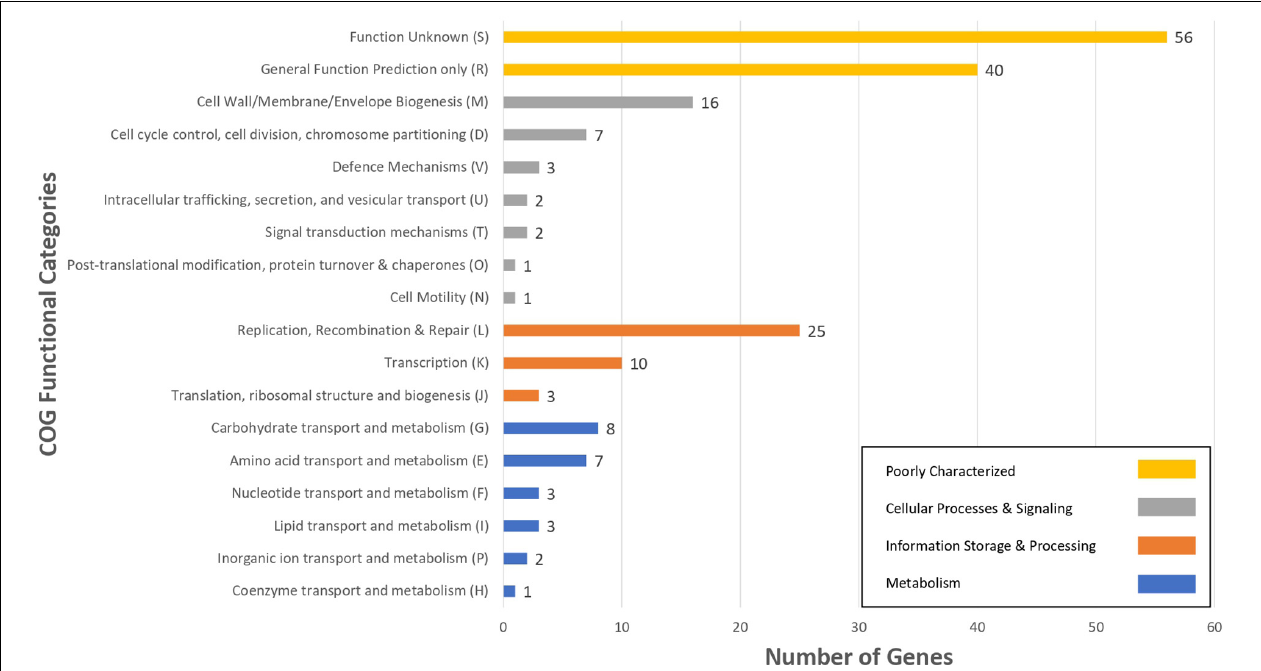
FIGURE 4 | The number of L. pentosus L33 strain specific genes, compared to 26 L. pentosus strains, assigned to COGs functional categories. Different bar colors represent the further classification of all functional categories into four major classes—Poorly Characterized (Yellow bars), Cellular Processes and Signaling (Gray bars), Information Storage and Processing (Orange bars) and Metabolism (Blue